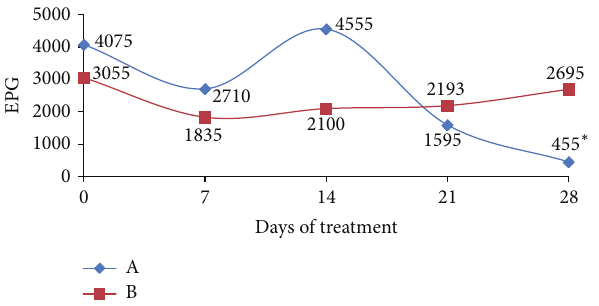
Figure 1: Mean number of eggs per gram of feces (EPG) in groups of dogs naturally infected with Ancylostomatidae: treated with probiotics (A) and untreated (B). ∗ meaning difference in the reduction ( 𝑃 < 0.05 ).